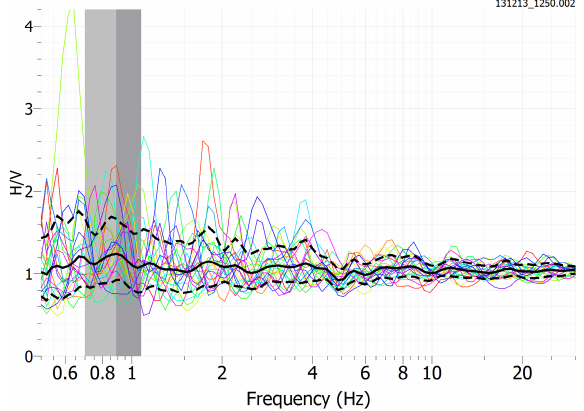
Figure 6. HVSR analysis of Lennartz LeD/5s velocimeter, for recording of 60min length, on the ground floor of old building of TEI